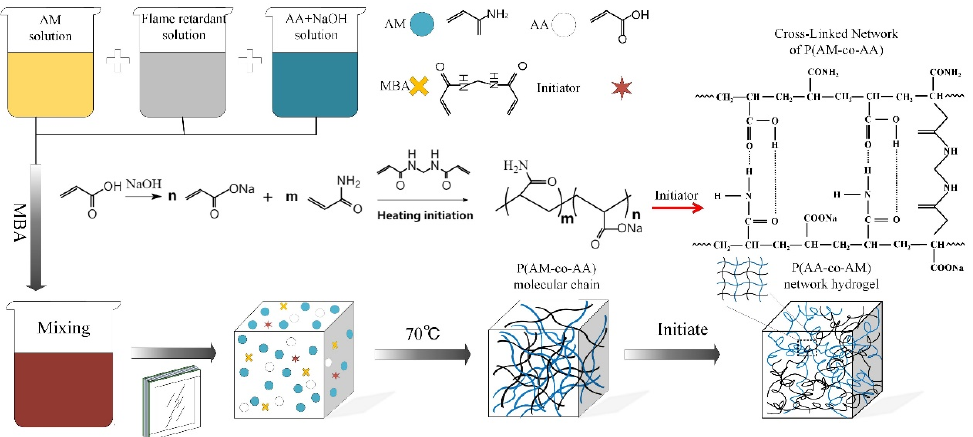
Figure 1. Preparation process of P(AM ‐ co ‐ AA) hydrogel.